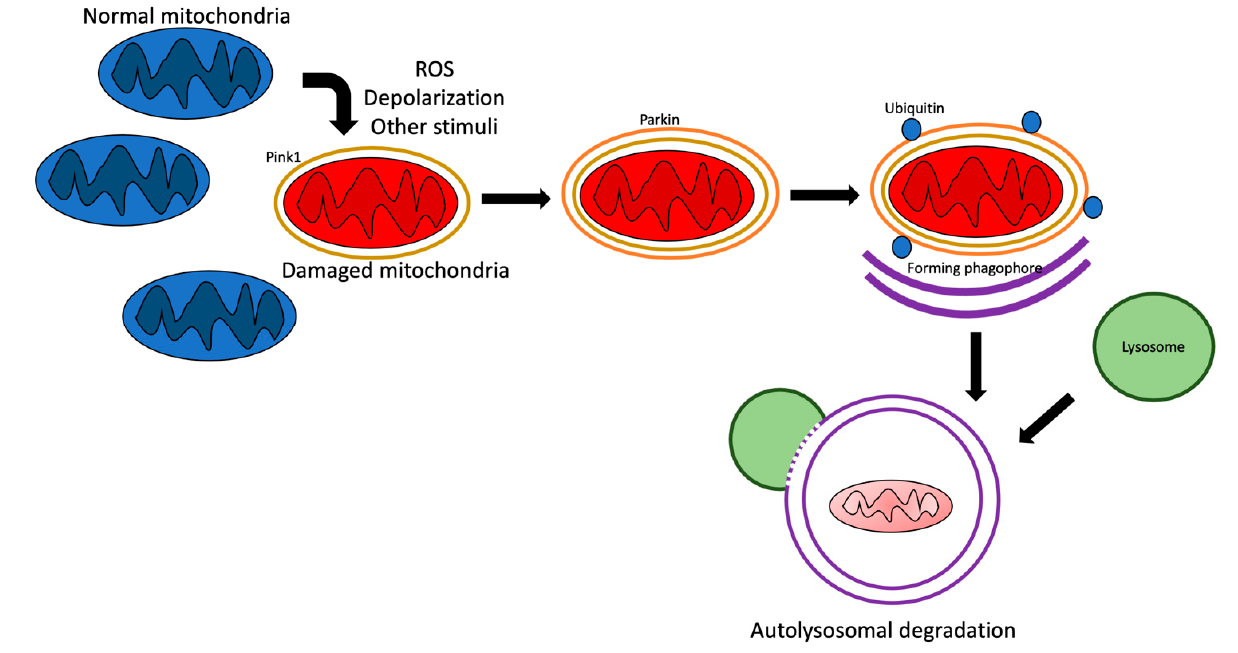
Figure 2. Schematic representation of the mitophagy process. ROS—reactive oxygen species. Additionally, mitophagy can be mediated by parkin-independent mechanisms. Cru- cial proteins for these mechanisms include Bcl2/adenovirus E1B 19-kDa protein-interact- ing protein 3 (Bnip3), Bcl2-like protein 13 (Bcl2-L-13), cardiolipin, FUN14 domain-contain- ing protein 1 (Fundc-1), and NIX [29]. Fundc-1 is also involved in the regulation of mito- chondrial fusion and fission through cooperation with Opa1 and Drp1, respectively, lo- cated in the OMM. Interplay with Opa1 also suppresses mitophagy and fission. In con- trast, Fundc-1 association with Drp1 triggers these processes [30].